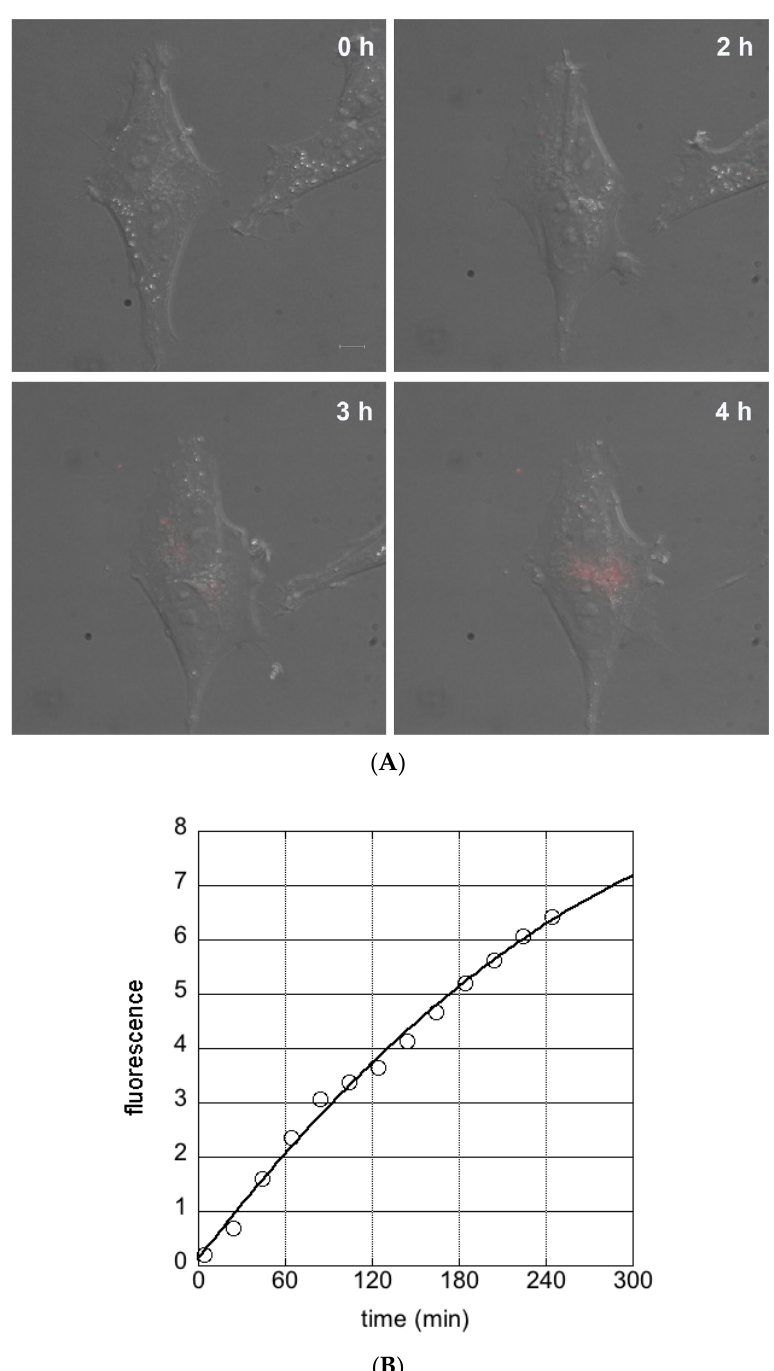
Figure 2. ( A ) time-lapse experiment of rhodaminated HFt uptake by neuroblastoma cells. SH-SY5Y cells were seeded in 8-well-plates and treated with 0.03 mg/mL rhodaminated HFt. Fluorescence images were acquired every 20 min for 4 h. Times: 0, 2, 3, 4 h (see also the Video S1 in Supplementary Materials). Scale bar: 10 µ m; ( B ) timecourse of the increase in fluorescence of SH-SY5Y cells upon incubation of rhodaminated HFt. y -axis shows mean rhodamine fluorescence intensity (AU) measured for each cell, upon subtraction of the mean background fluorescence (average of eight cells).